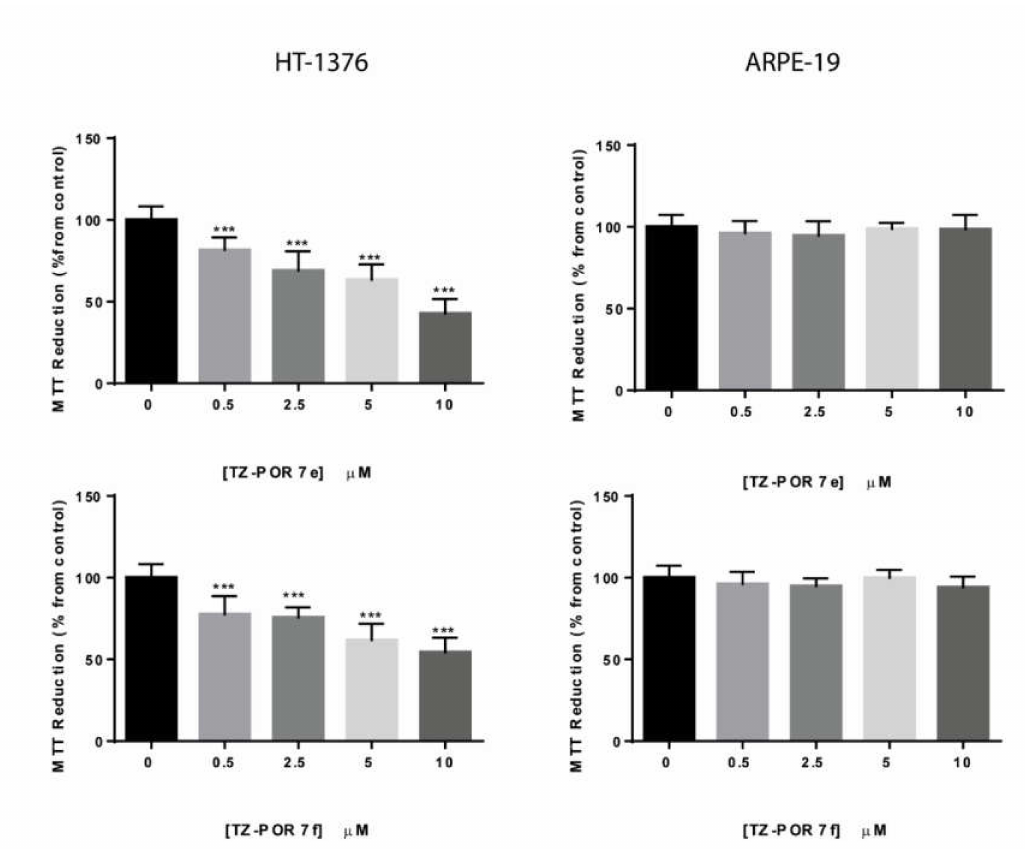
Figure 5. Cell survival of HT-1376 and ARPE-19 cells, incubated in the dark during 4 h with PSs PVP-TZ-POR 7e and 7f at di ff erent concentrations and irradiated with white light for 40 min with an irradiance of 20 mW.cm -2 . Data are the mean value ± S.D. of at least three independent experiments performed in triplicates: *( p < 0.05), **( p < 0.01), ***( p < 0.001) significantly di ff erent from MTT reduction of the control